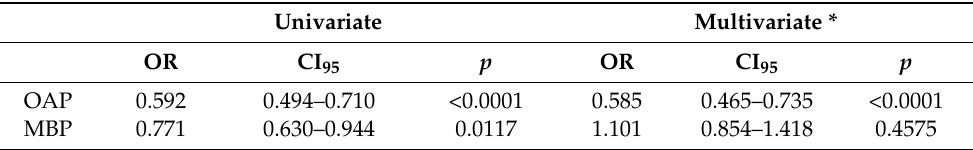
Table 7. Effect of OAP and MBP on organ-space